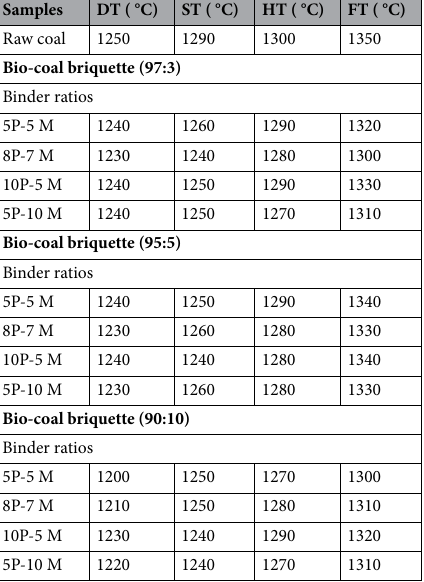
Table 3. Ash fusion temperatures of raw coal and bio-coal